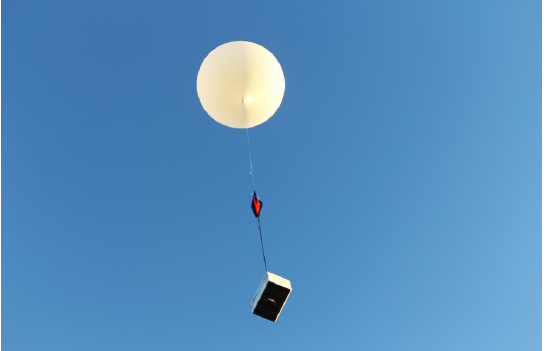
Figure 1. A meteorological balloon carrying infrasound sensors in a PolarTech insulated shipping container in 2015. The parachute is visible between the box and the balloon. The Skyfall set-up is very similar to the one shown and described here.